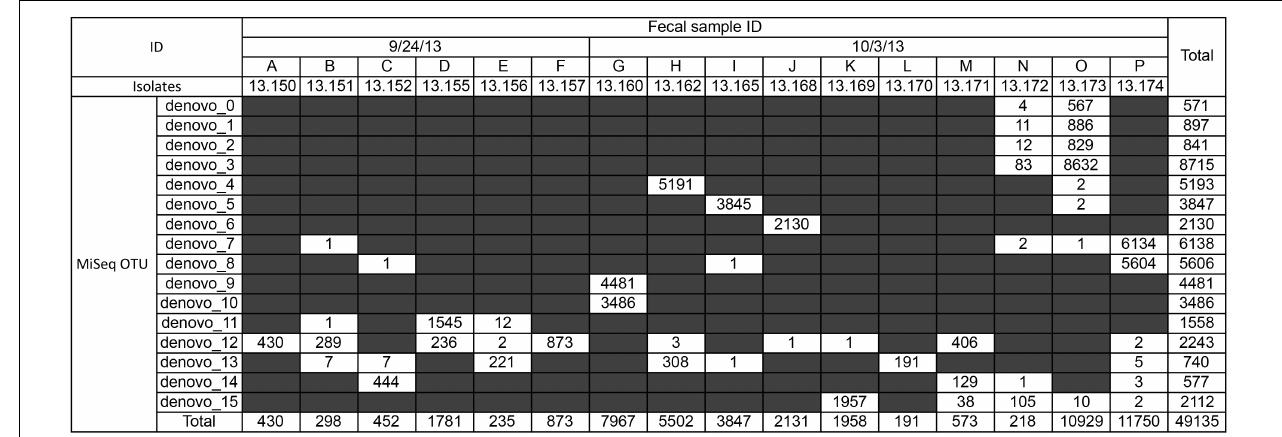
FIGURE 2 | Number of sequence reads for each flaA operational taxonomic units (OTUs) in each fecal sample. Sequences were obtained by MiSeq analysis, and clusterd into OTU by using the SHI7 program (Al-Ghalith et al., 2018). Strain ID isolated from each fecal sample is also